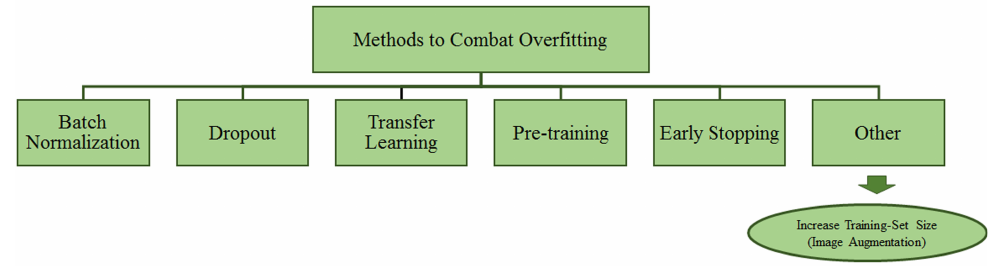
Figure 2. Methods to tackle